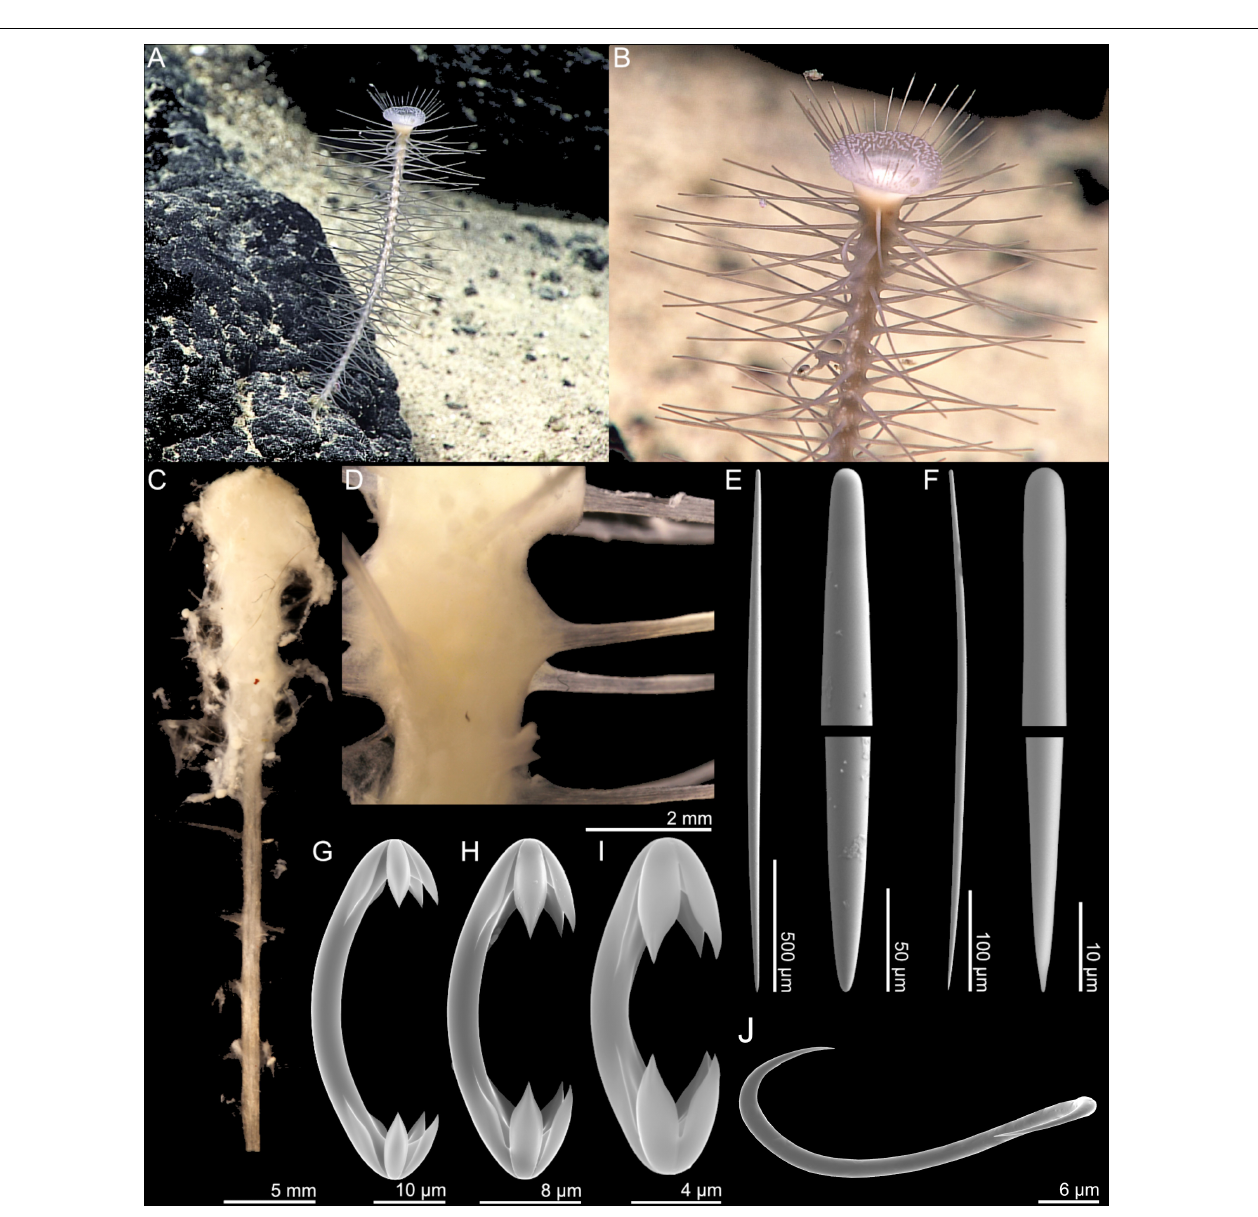
FIGURE 7 | Chondrocladia coronata n. sp. (A,B) In situ images from ROV feed, (C) whole specimen, (D) stem detail, (E) style, (F) subtylostyle, (G) anchorate chela 1, (H) anchorate chela 2, (I) anchorate chela 3, and (J) sigma.